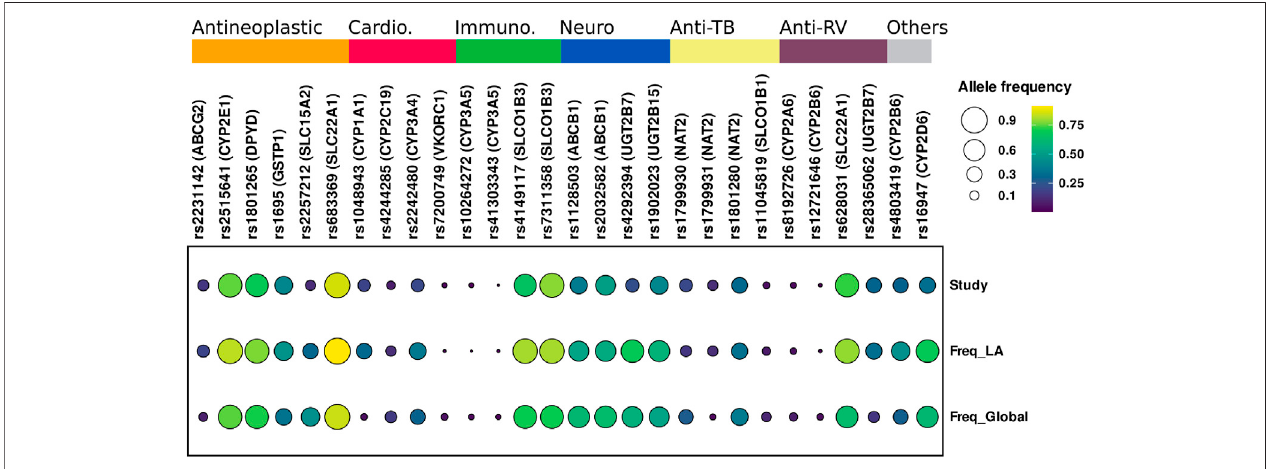
FIGURE 2 | Comparison of allelic frequency of variants with clinical pharmacogenetic effect. Study, Data generate in this study; Freq_LA, Allele frequency Latin- American population; Freq-Global, Allele frequencies global. Genes and rs related to Antineoplastic, Cardio, Cardiovascular; Immuno, Immunosuppressant; Neuro, Neuropsychiatric; Anti-TB, Anti-tuberculosis; Anti-RV, Antiretrovirals drugs.